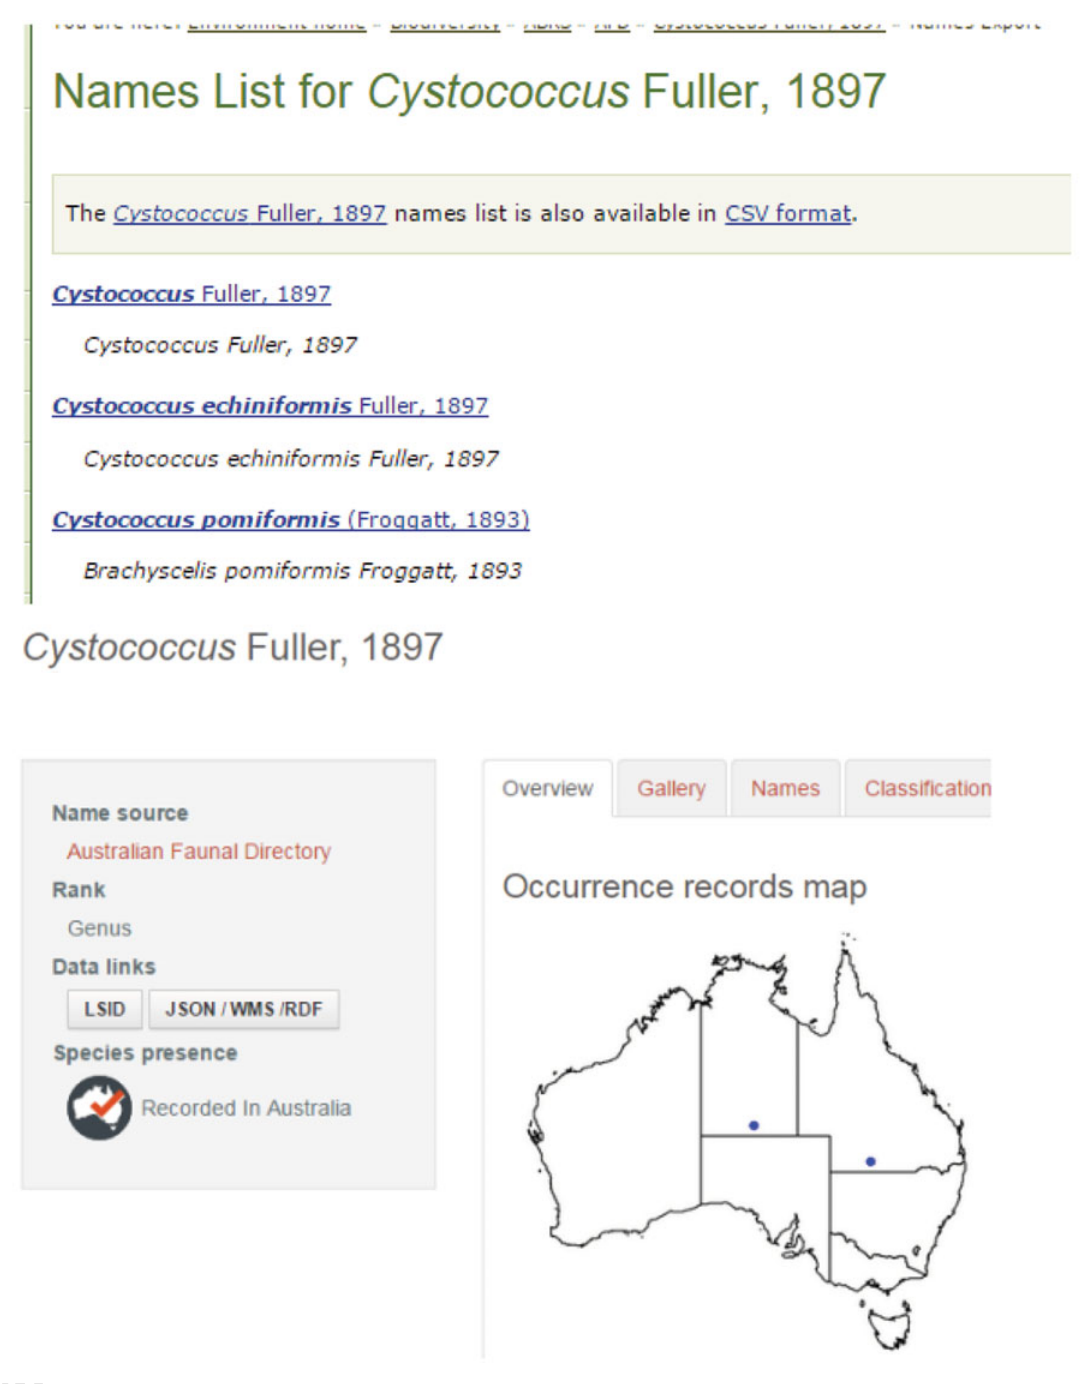
(Colour online) Atlas of Living Australia